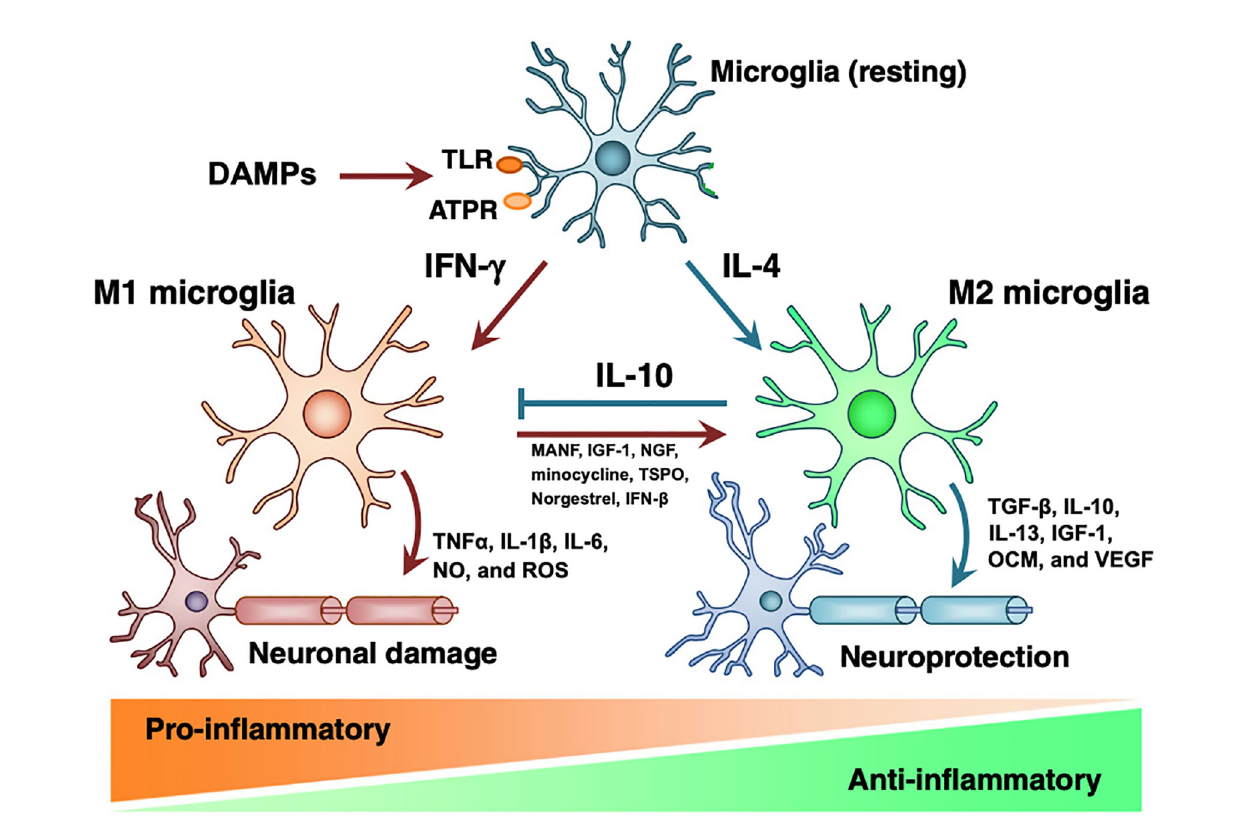
FIGURE 1 | Microglial M1 and M2 phenotypes. DAMPs act on PRRs on resting microglia to induce formation of M1 or M2 microglia. M1 microglia induce pro- in fl ammatory state and tissue damage by releasing TNF a , IL-1 b , IL-6, nitric oxide, and ROS. M2 microglia have tissue-protective effects via TGF- b , IL-10, IL-13, IGF-1, OCM, and VEGF. While IL-10 inhibits M1 microglia, introduction of MANF, IGF-1, minocycline, TSPO, norgestrel, and IFN- b B induce transition to M2 phenotype. Modi fi ed from Nakagawa 2015 with notes from Kramer 2019, Elsevier license 4858840650798 (41,